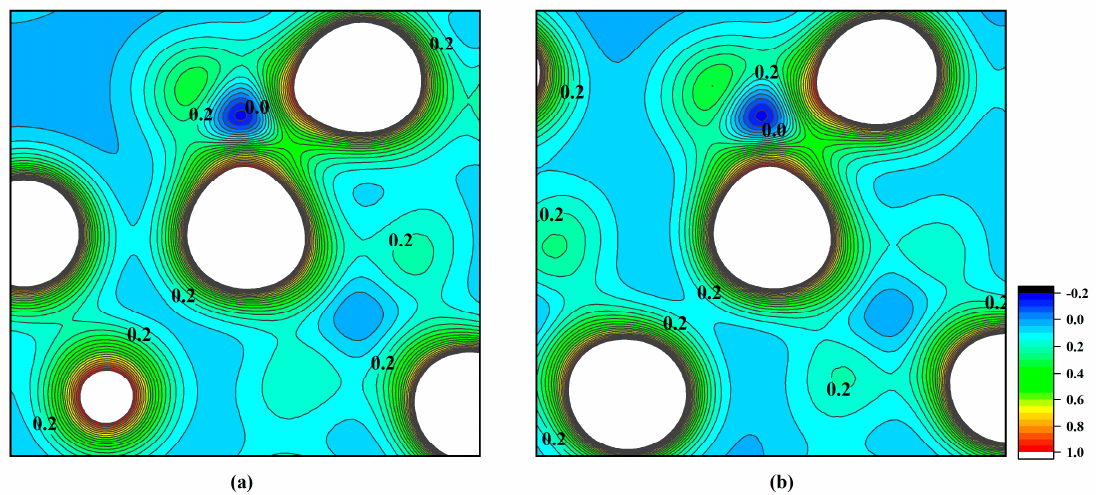
Figure 6. The density of states of the Na-MMT at 19.92 GPa ( a ) and Mg-MMT at 20.32 GPa ( b ).